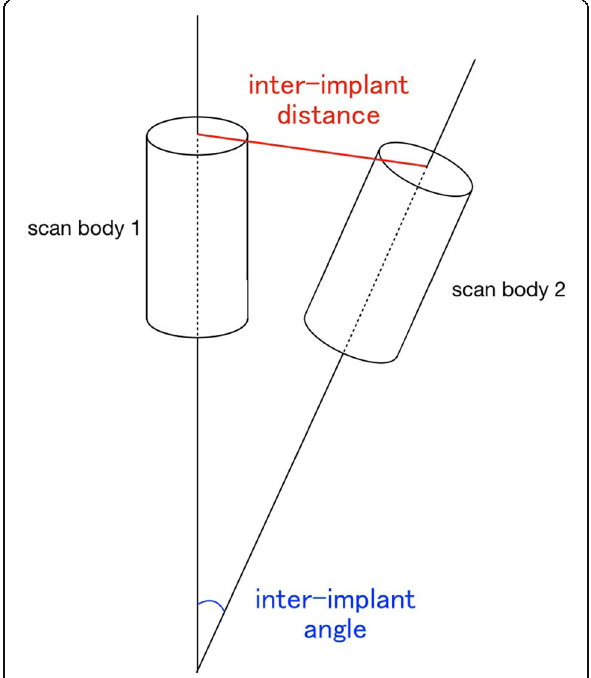
Fig. 3 Schematic image indicating the inter-implant distance and inter-implant